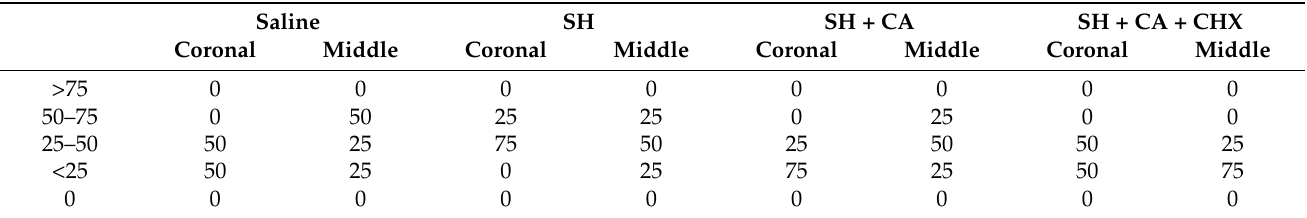
Saline, control; SH, sodium hypochlorite; CA, citric acid; CHX,